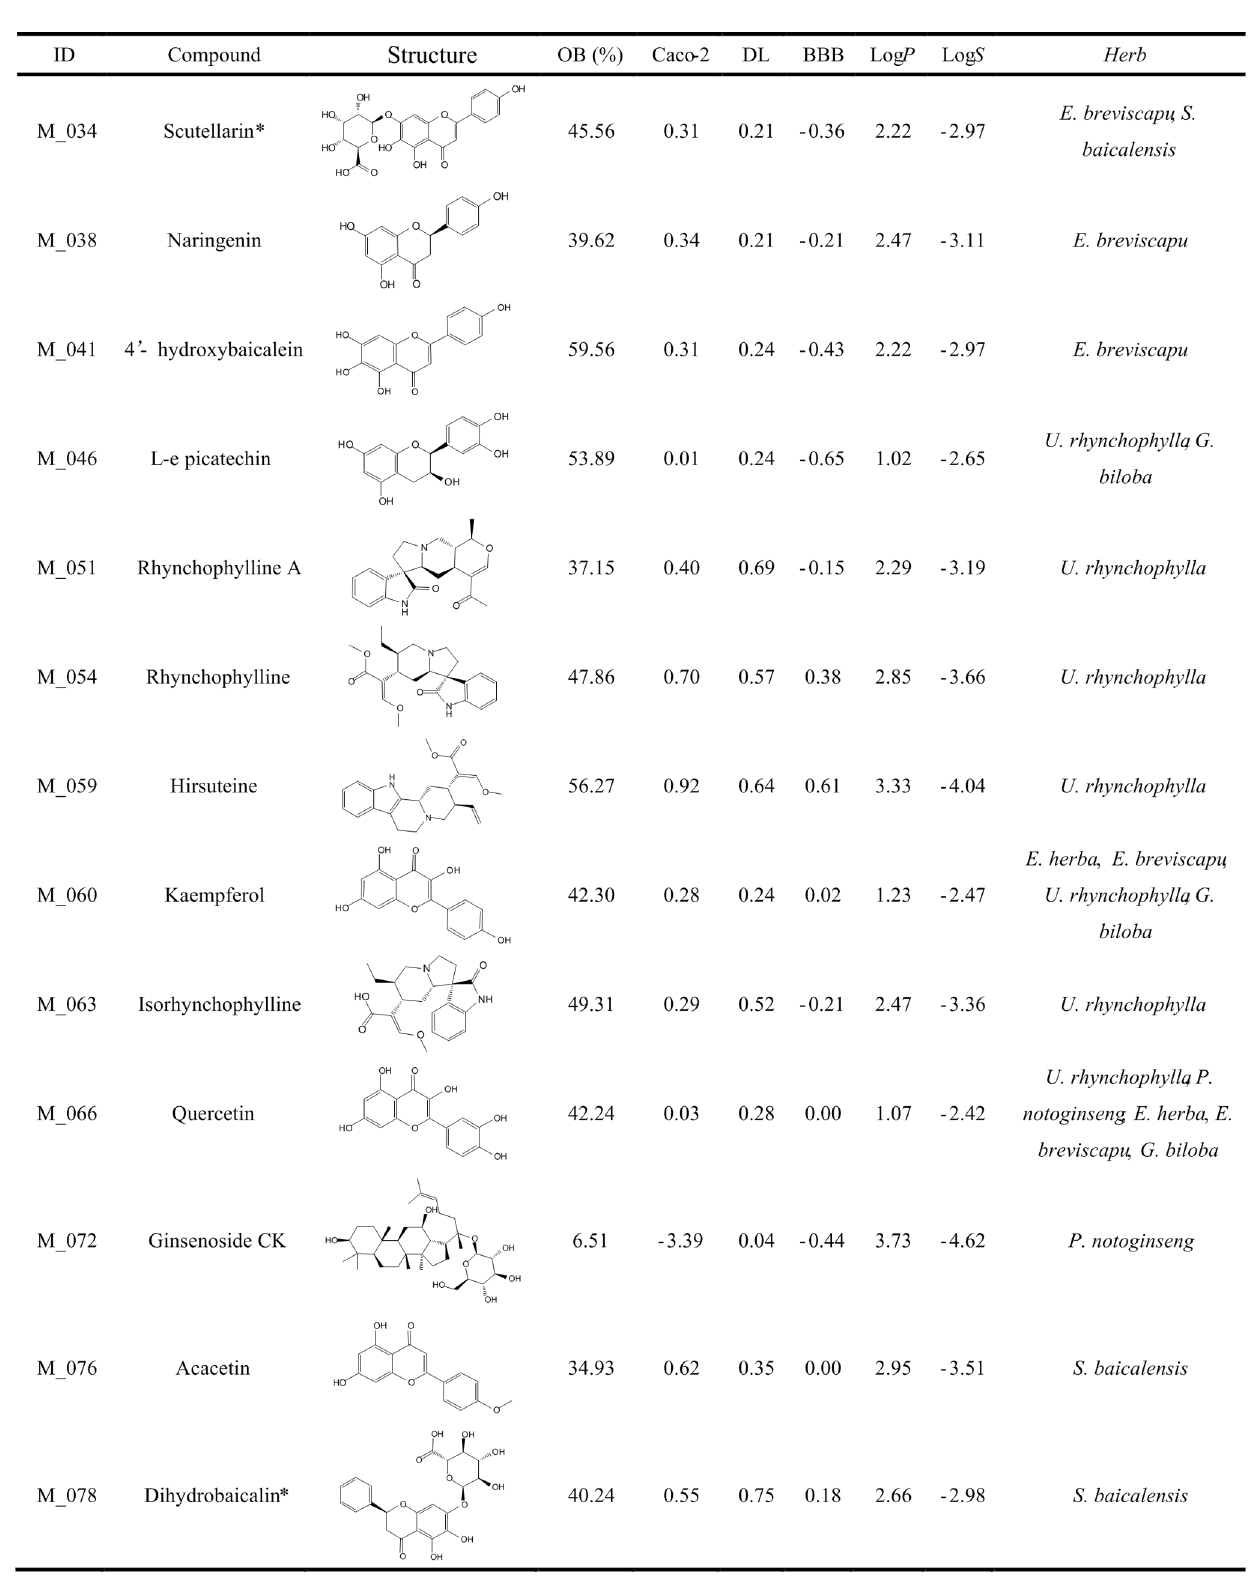
Figure 2. Representative active constituents of anti-stroke herbs and their corresponding ADME parameters (Part 2). The sign * represents the molecule after deglycosylation.